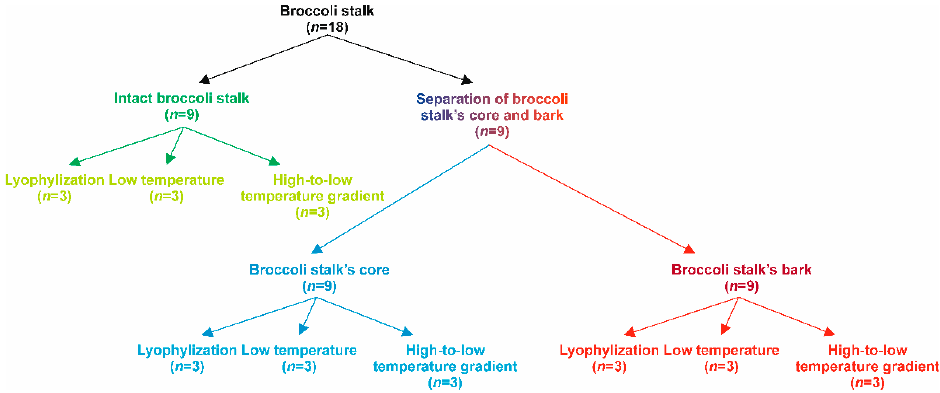
Figure 1. Schematic representation of the experimental design and processing scheme. All materials (complete discs, cores, and barks of stalks) were used to prepare ana- lytical extracts following three different procedures. For this purpose, samples (100 mg) were first homogenized in 1 mL of ethanol/deionized water (50:50, v / v ) and then extracted (i) at 70 °C, for 20 min, with vortex shaking every 5 min. All the obtained extracts were centrifuged at 4000 rpm, for 5 min, filtered through a 0.22 μ m PVDF filter (Millipore, MA, USA), and kept at − 20 °C until chromatographic analysis [13,17]. 2.3. In Vitro Simulated Gastrointestinal Digestion Simulated gastrointestinal digestions were performed on brassica stalks powder fol- lowing the methodology previously described [13]. Briefly, for the gastric digestions, the samples (500 mg) were mixed with 15 mL of simulated gastric fluid (SGF) stock electrolyte solution containing a mixture of salts simulating the composition of the SGF and the pep- sin enzyme (EC 3.4.23.1) at the final concentration of 2000 U/mL. The final pH was ad- justed to 3.0. The gastric digestion of the plant material in the SGF was performed for 2 h, at 37 °C, under continuous stirring. During incubation, the pH was double-checked every 15 min and corrected when necessary to ensure a constant pH of 3.0. The reaction was stopped by adding sodium hydroxide solution (0.2 M). To simulate intestinal digestions, the simulated intestinal fluid (SIF) was prepared by dissolving a mixture of salts in deion- ized water, as described in the literature [13]. On the prepared SIF, the enzymatic activity characteristic of intestinal digestion was achieved by mixing pancreatin (EC 232-468-9) and pancreatic lipase (EC 3.1.1.3) at the concentrations of 100 U/mL of trypsin activity and 64 U/mL of lipase activity for pancreatin and 2000 U/mL for pancreatic lipase. Frozen por- cine bile salts were added to achieve the final concentration of 10 mM. The pH of the SIF was adjusted to 8.0. Again, the intestinal digestions were performed for 2 h at 37 °C in a thermal bath under continuous stirring [13]. After gastrointestinal digestion, the samples were centrifuged at 2000 rpm, for 5 min, at 4 °C to separate the soluble or bioaccessible fraction and the residual fraction. The bio- accessible fractions were filtered through a 0.22 μ m PVDF filter (Millipore, MA, USA) and analysed by HPLC-PAD-ESI-MSn for phenolic compounds and GSL, and UHPLC-ESI- QqQ-MS/MS for ITC and nitriles. 2.4. HPLC-PAD-ESI-MSn Analysis of the Quantitative Glucosinolate and Phenolic Profiles The chromatographic separation and spectrometry analysis of GSL and phenolic compounds present in the analytical extracts and gastrointestinal digestion products was performed following the methodology described by Baenas et al. and Abellán et al. [16,23]. The tentative identity of the phenolic compounds and GSL was attained according to the retention time (min), parent ions, and fragmentation patterns, in comparison with authen- tic standards and descriptions available in the literature [17] (Supplementary Tables S1